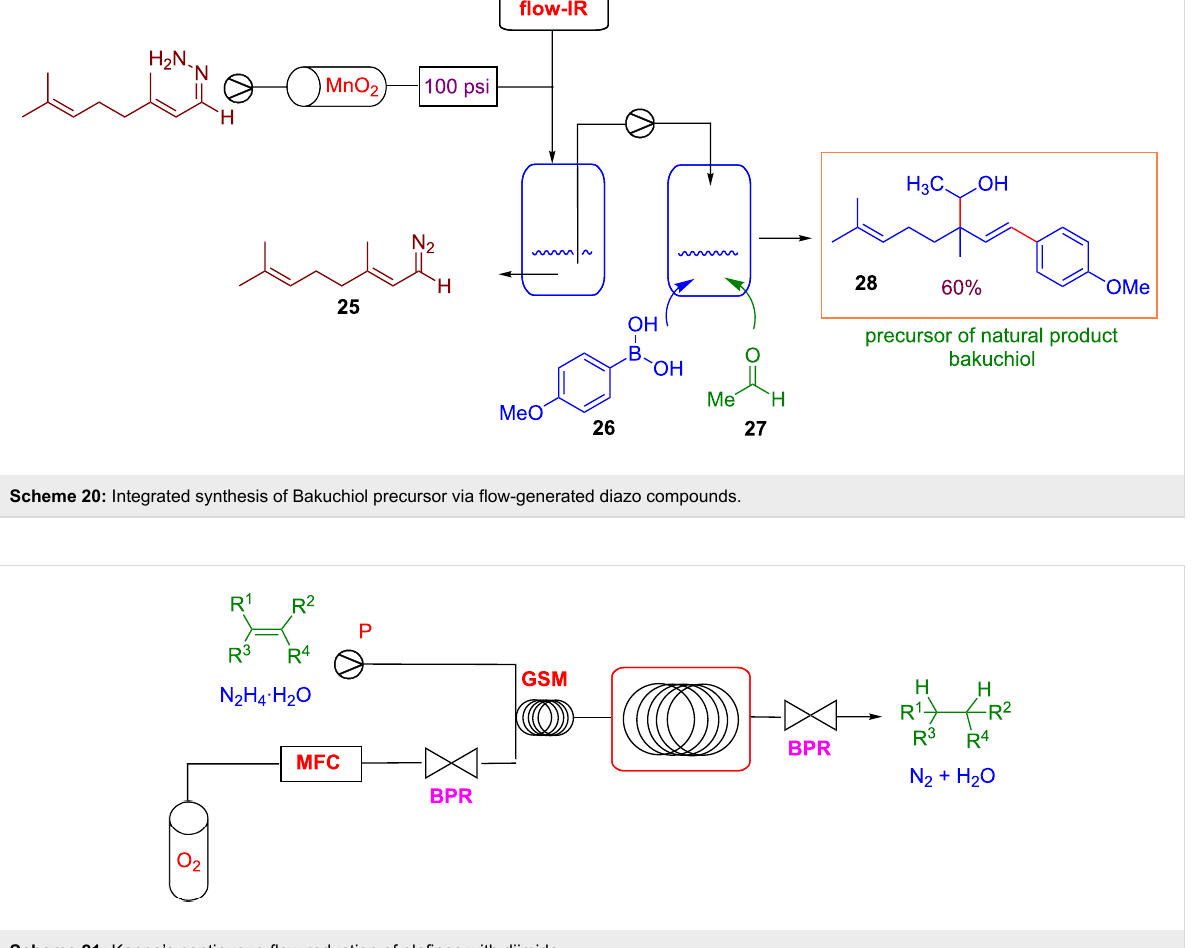
Scheme 21: Kappe’s continuous-flow reduction of olefines with